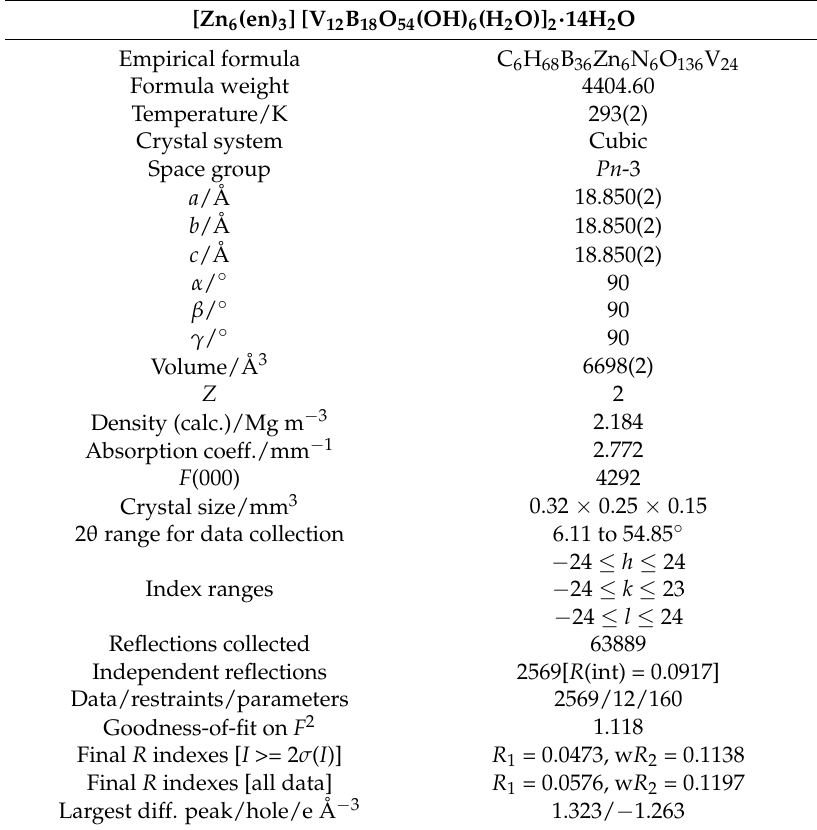
Table 1. Crystallographic data of compound 1